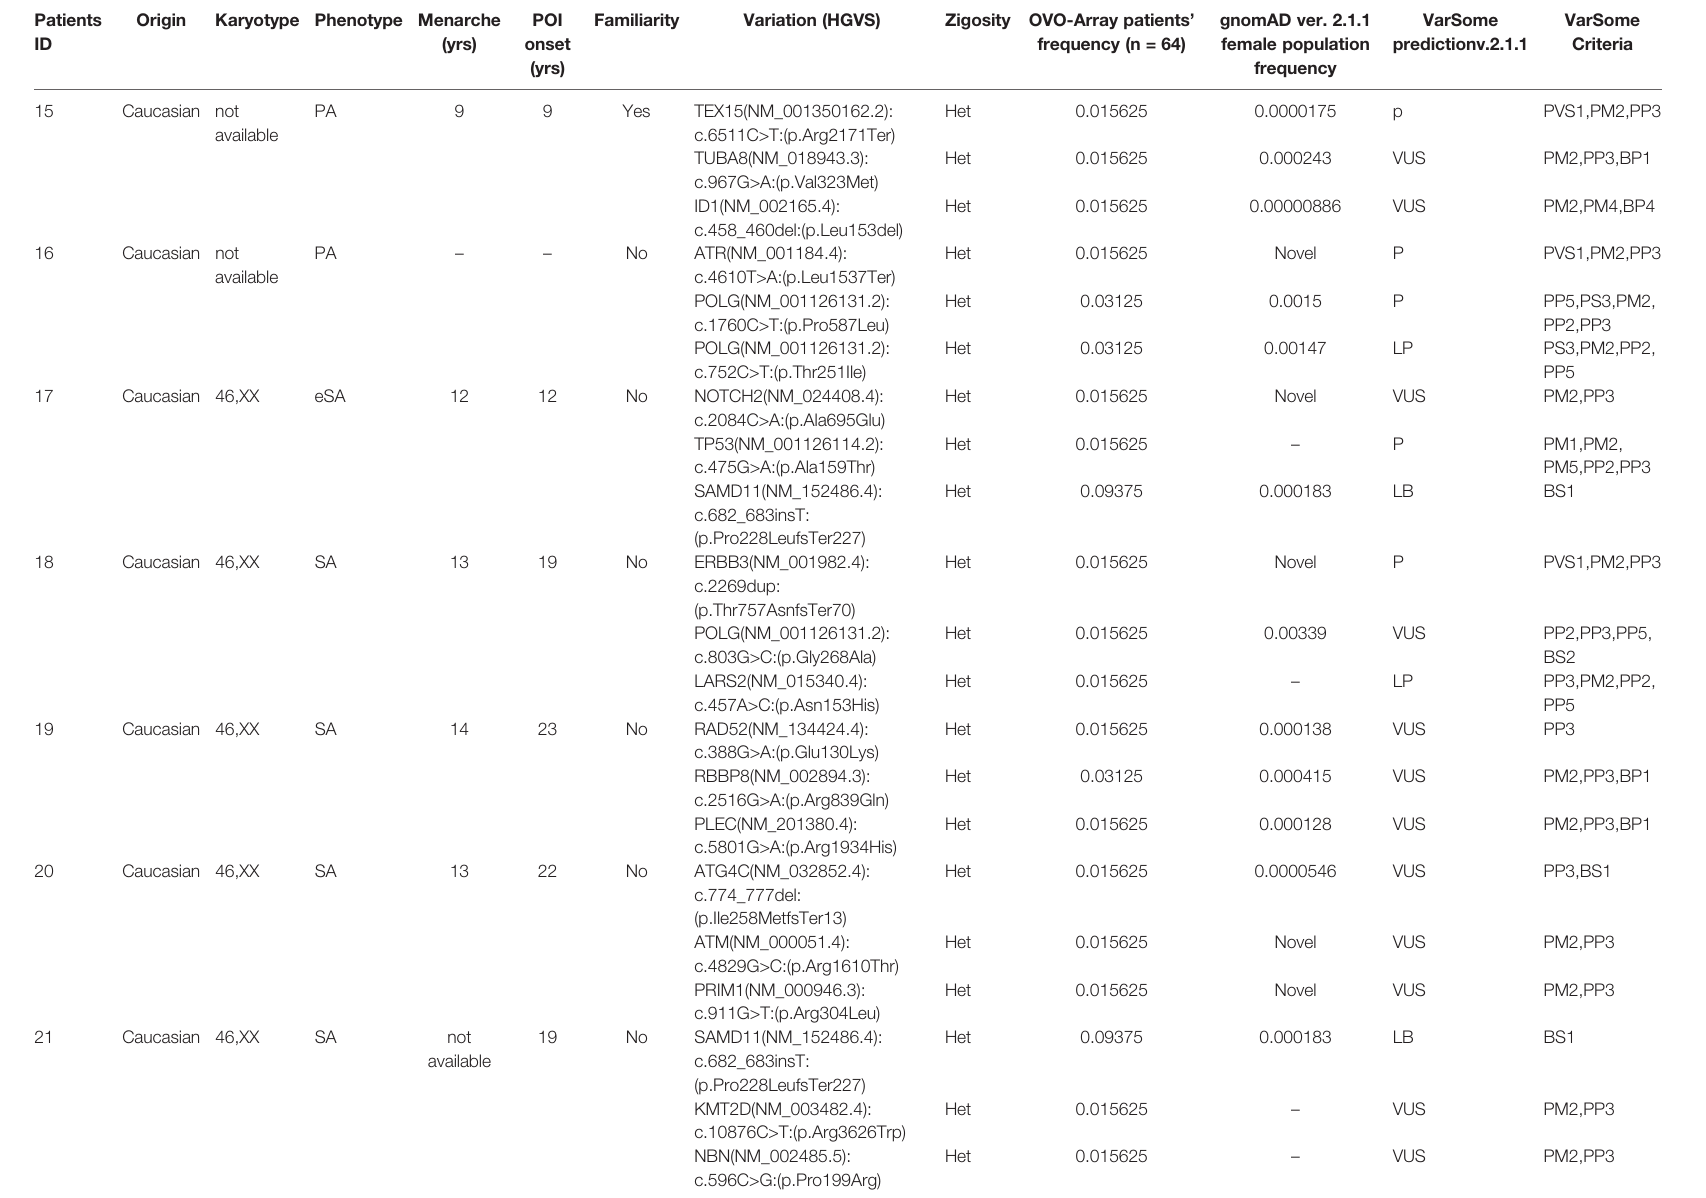
TABLE 4 | Correlation among severity, phenotype and pathogenicity predictions in patients with 3 variants in potentially POI genes. Patients